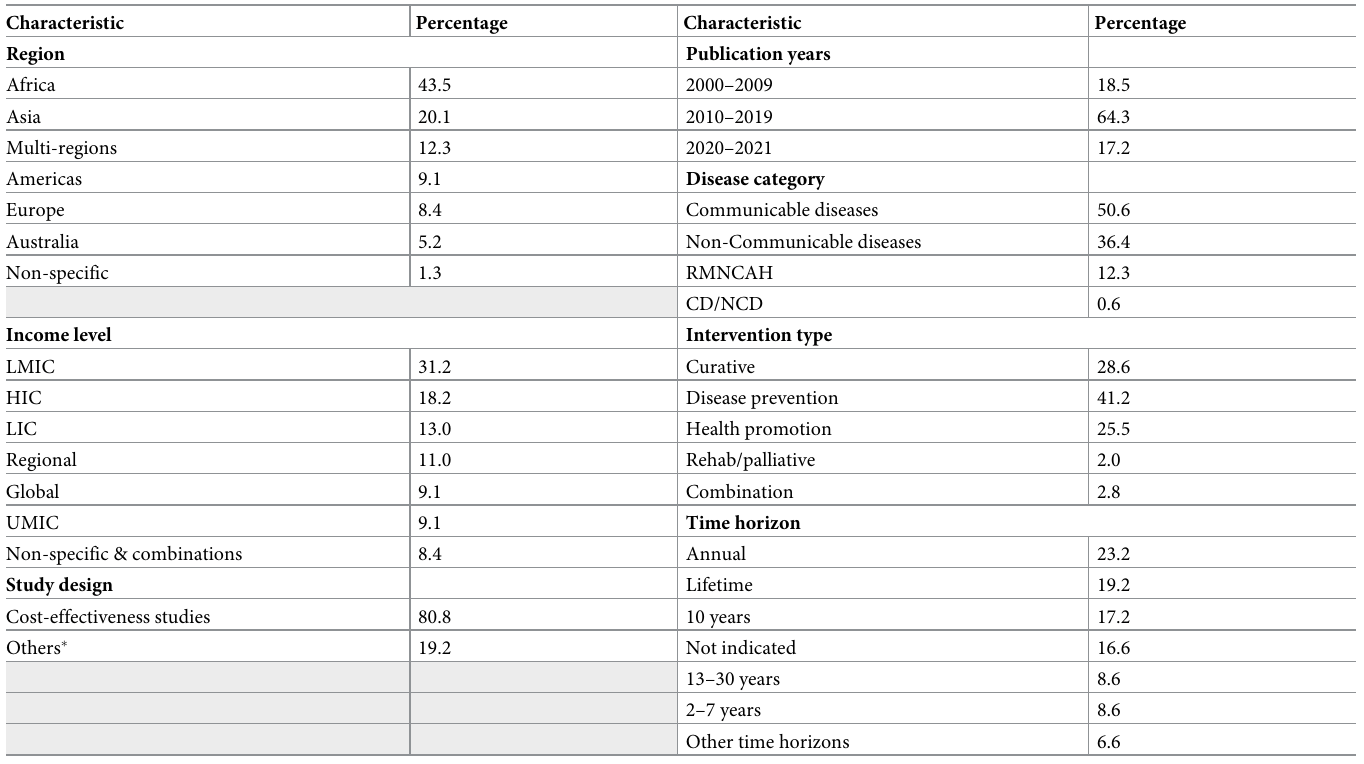
Table 1. Characteristics of included studies.